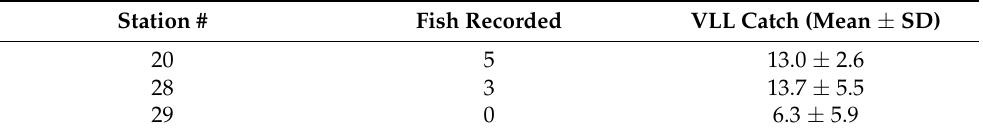
Table 1. McMurdo Sound, total number of fish recorded with BRUV during the first hour of setting at each station, and average vertical longline (VLL) catch values obtained from three deployments at each station.